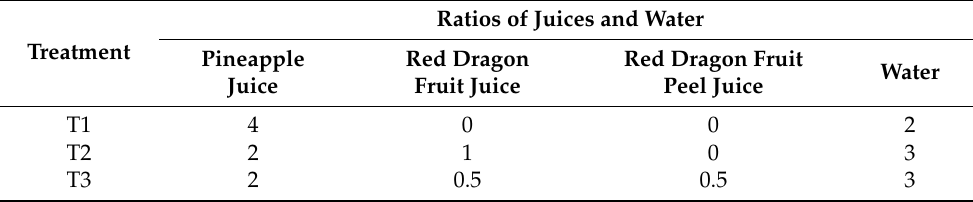
Table 1. Ratios of pineapple juice to water and pineapple juice to red dragon fruit juice. Ratios of Juices and Water Treatment Pineapple Red Dragon Red Dragon Fruit Juice Fruit Juice Peel Juice